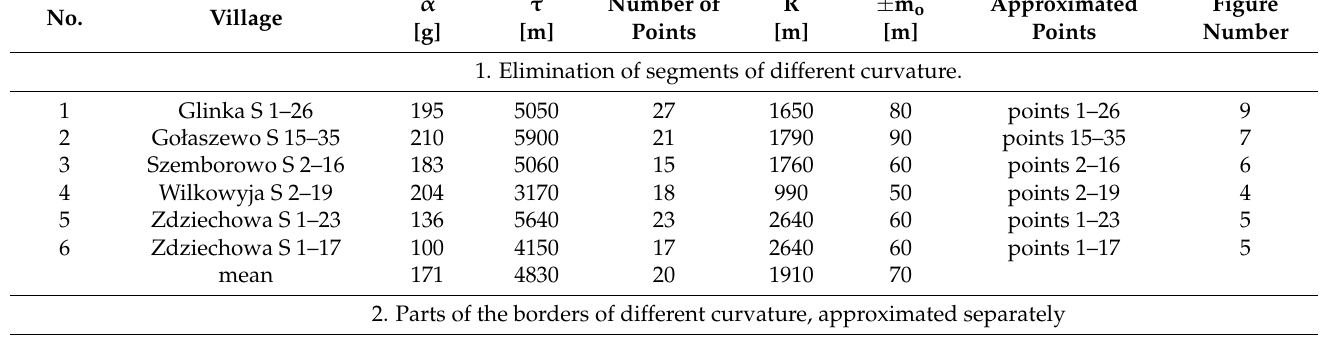
Table 3. Values of geometric elements of the boundary arcs for the approximation with elimination. 1. Elimination of segments of different